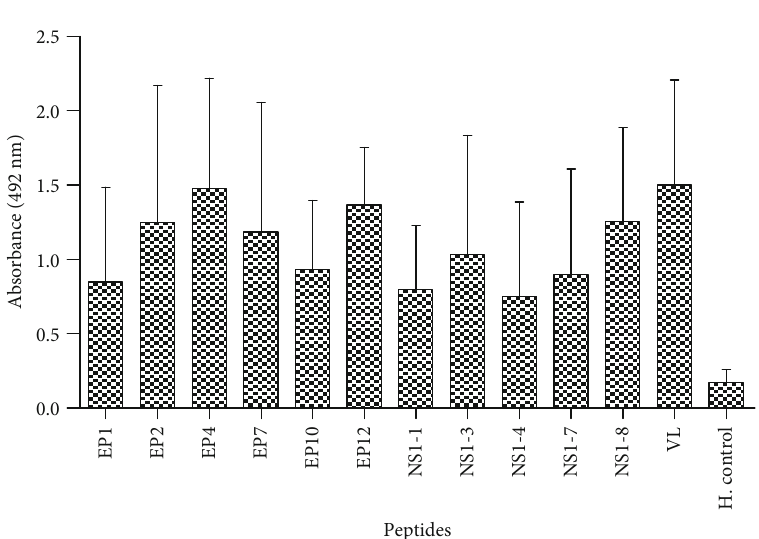
Figure 3: IgG antibody reactivity with six peptides of envelope (E), fi ve peptides of NS1 protein, and virus lysate (VL, positive control) in DENV-positive sera ( n = 150 ) and healthy controls ( n = 28 ). All the peptides showed p < 0 : 0001 value, and NS1-4 showed p < 0 : 001